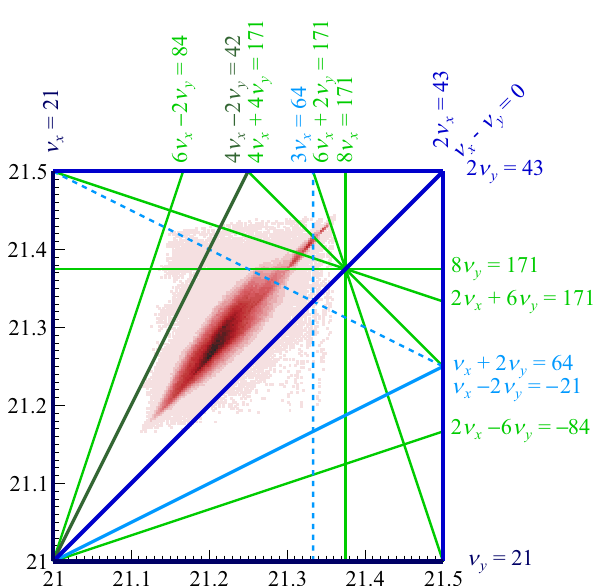
FIG. 1. Tune spread distribution obtained by the S pace C harge T racker ( SCTR ) [13,14] simulation and major resonances (lines) in FX operation. The individual tunes were obtained via Fourier analysis using the data from the 5000th to the 5511th turn. The used parameters are listed in Table II.